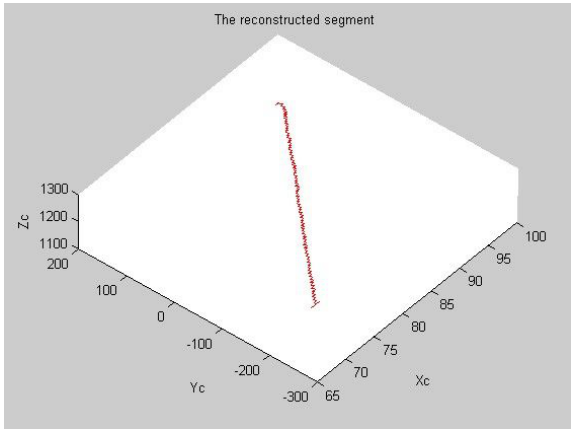
Fig. 8. The reconstructed image of